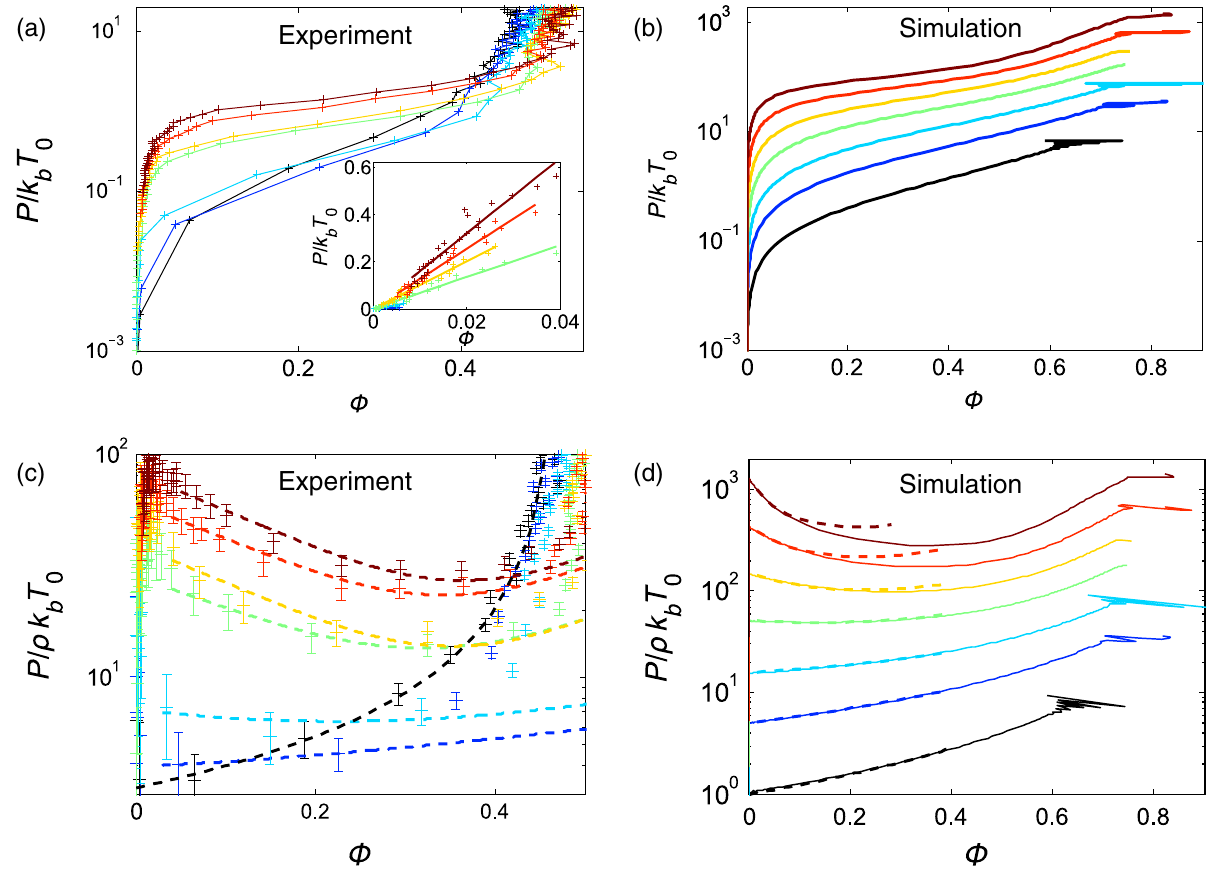
T 0 Þ versus linear density ϕ for (a) experiment and B . eff